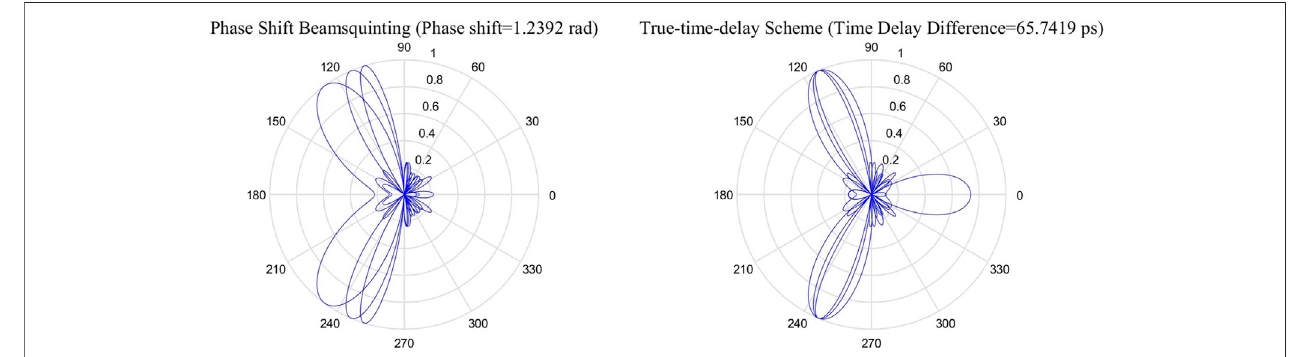
FIGURE 7 | Illustration of the beam squinting